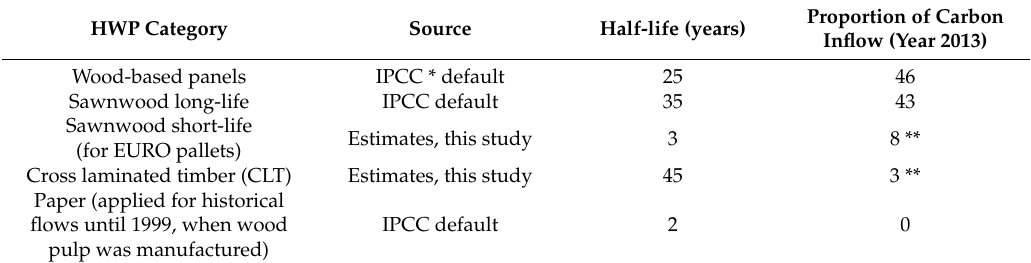
Table 3. Half-life of harvested wood products (HWP)